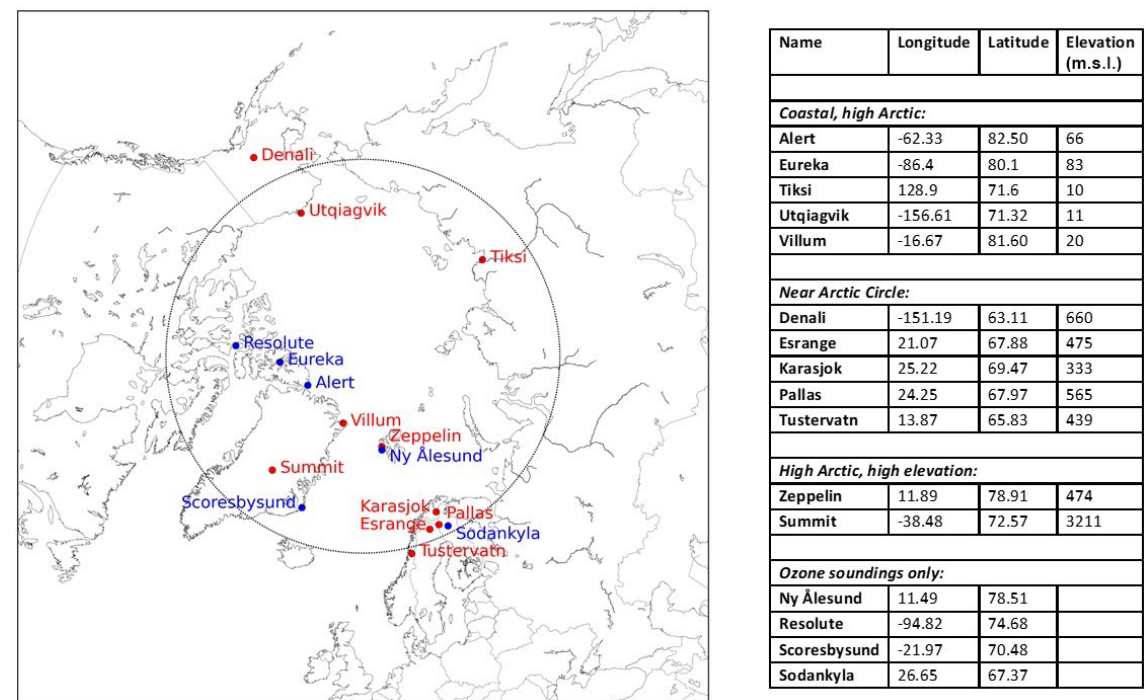
Figure 4. Map of the surface (red) and ozonesonde (blue) sites cited in the present study, with coordinates and elevation. Eureka and Alert are both surface and sounding sites. Utqia˙gvik was formerly called Barrow. The Arctic Circle at 66.55 ◦ N is also shown in the figure for